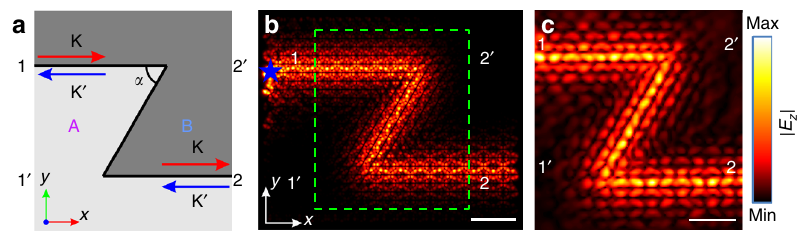
Fig. 6 Topological protection of the edge state in a Z-shaped waveguide. a Schematic diagram of a Z-shaped topological waveguide formed between patterns A and patterns B. The corner angle α = 60°. b Simulated fi eld map of E z component at 7.50 GHz. The green dashed rectangle denotes the region of the area 208 × 220 mm 2 scanned in experiments. The color indicates the amplitude of E z component. The scale bar is 60 mm. c Measured fi eld map of E z component at 7.50 GHz. The color indicates the amplitude of E z component. The scale bar is 40